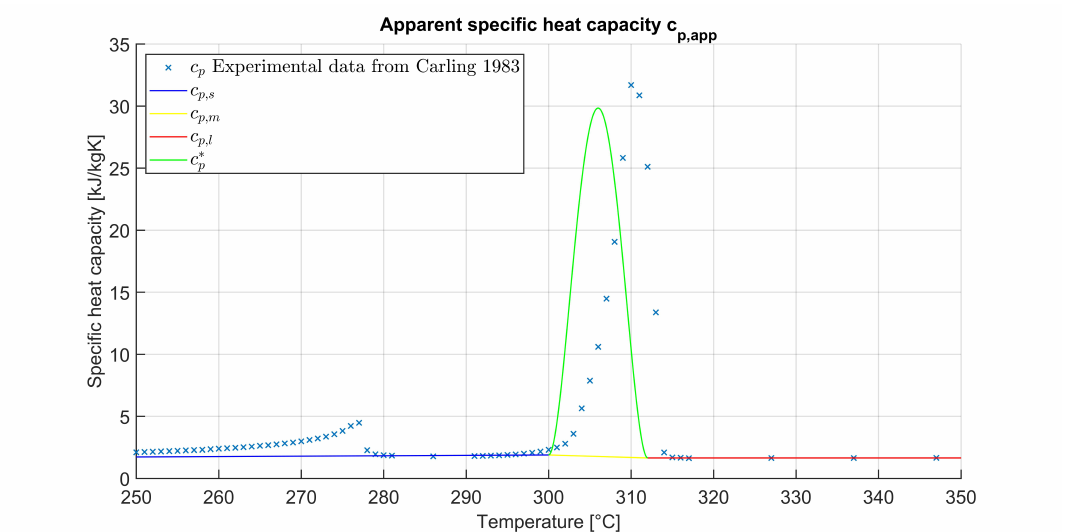
Figure 4. Apparent specific heat capacity c p , app for sodium nitrate.